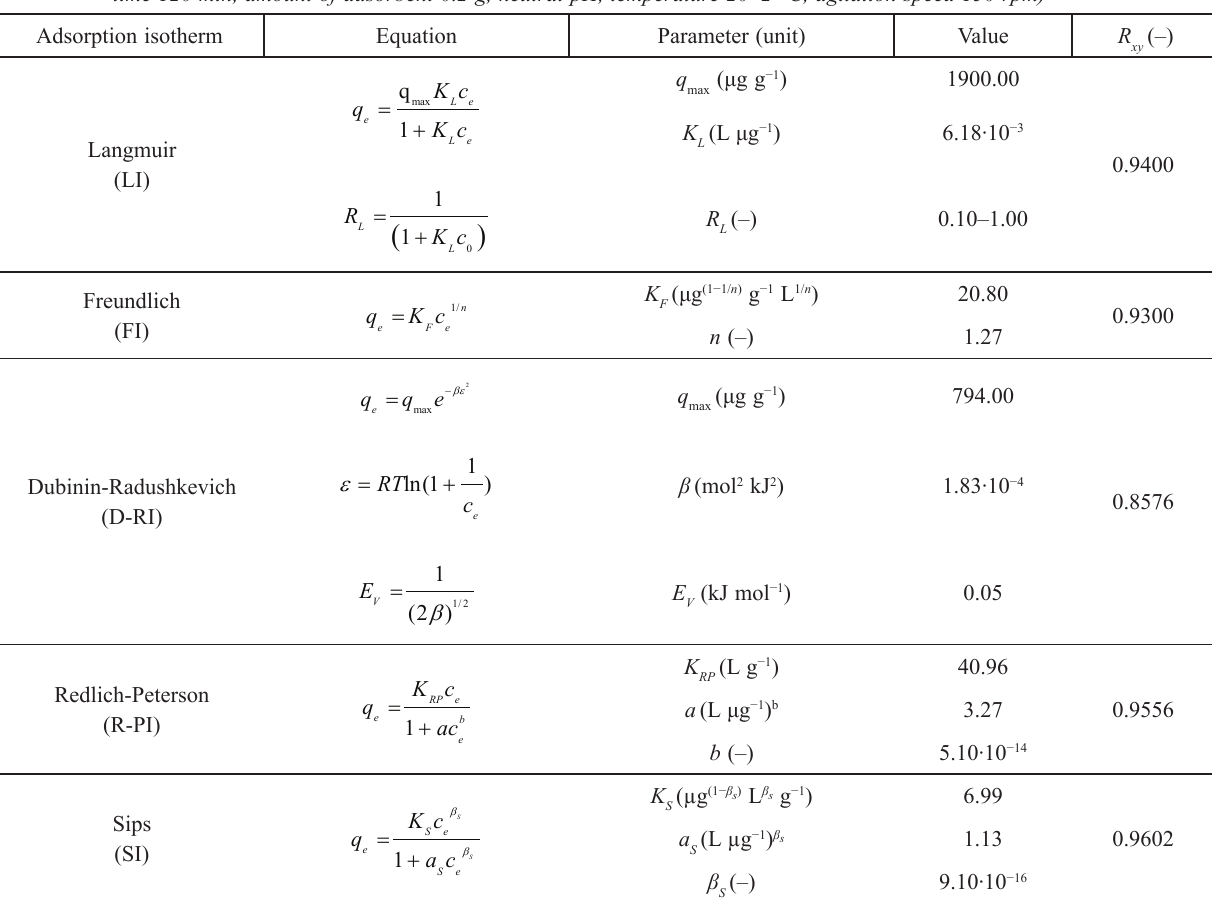
Table 3 – Isotherm data for adsorption of As(V) onto GFO (As(V) concentration 0–1000 μg L −1 , volume of solution 0.1 L,